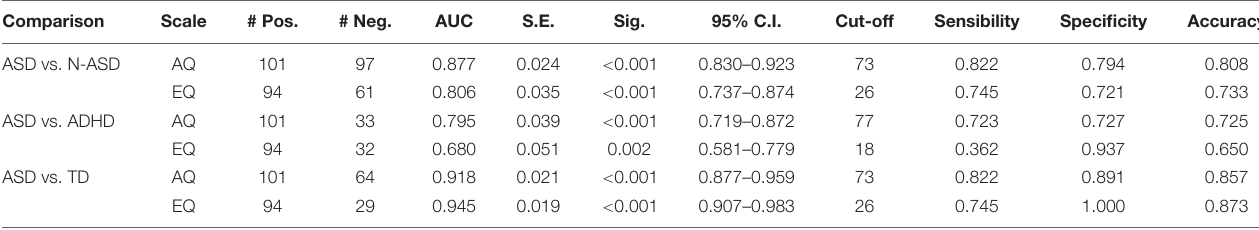
TABLE 2 | ROC analysis and accuracy for different combination of groups. Comparison Scale # Pos. # Neg. AUC S.E. Sig. 95% C.I. Cut-off Sensibility Specificity Accuracy ASD vs.